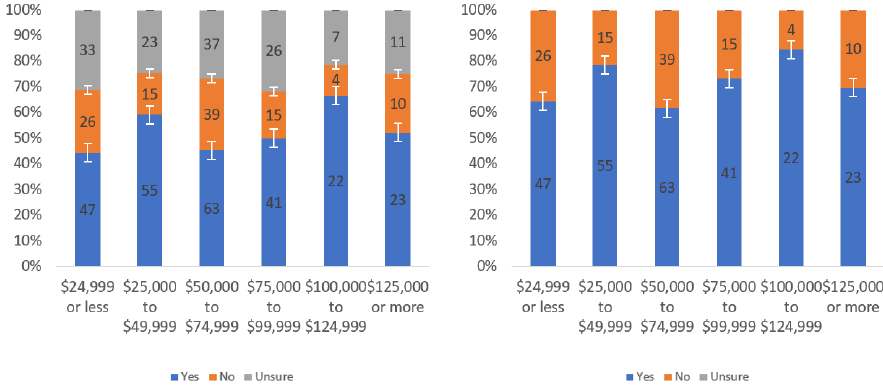
Figure 32. Responses regarding others’ willingness to review by income level including ( left ) and excluding ( right ) unsure responses.